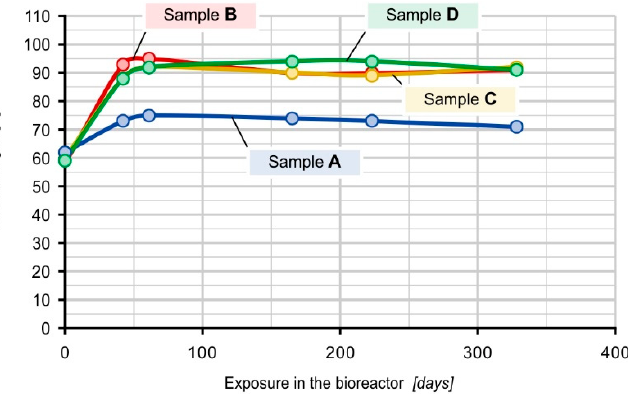
Figure 5. Contact angle values for reference samples and samples placed in the bioreactor.